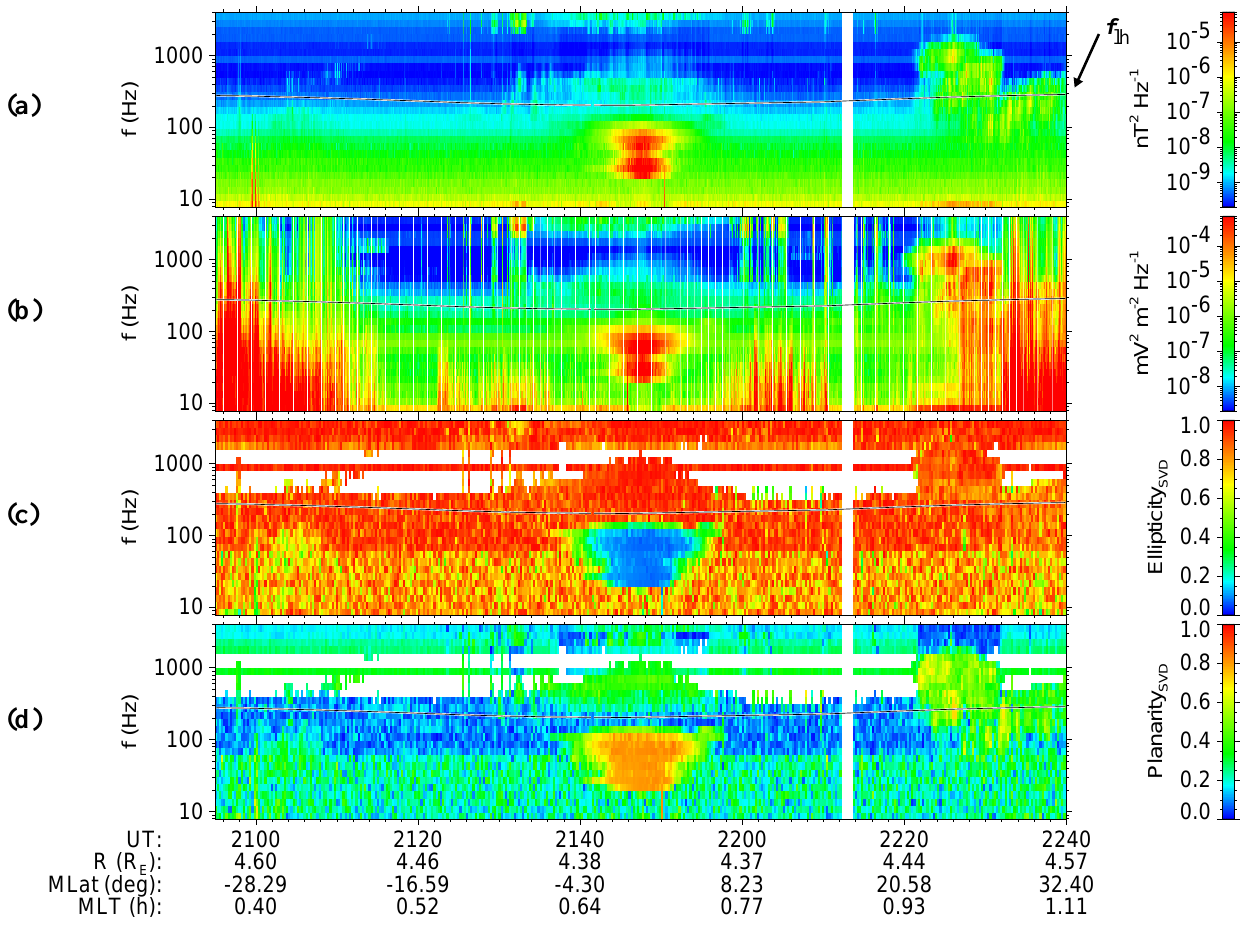
Fig. 1. Example of data collected by Cluster 4 on 17 February 2002. From the top: (a) sum of the power-spectral densities of the three magnetic components, (b) sum of the power-spectral densities of the two electric components ; (c) ellipticity and (d) planarity are determined using the singular value decomposition of the magnetic spectral matrix. Universal time (UT) and position of the spacecraft are given on the bottom of the figure using the radial distance (R) in the Earth radii (R E ), magnetic dipole latitude (MLat) in degrees, and magnetic local time (MLT) in hours. Maximum possible value of the local lower hybrid frequency ( f lh ) is plotted over the panels (a)–(d). The data in panels (c) and (d) are not shown for weak signals below 10 − 9 nT 2 Hz − 1